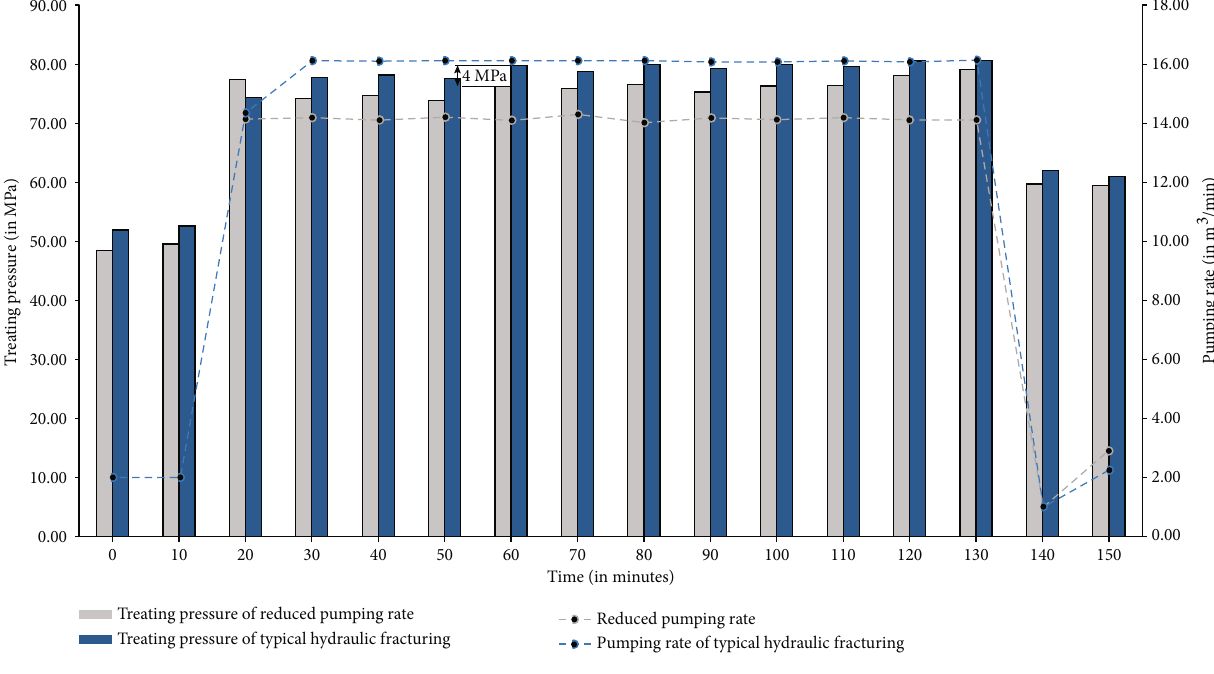
Figure 14: The comparison of treating pressure corresponding to di ff erent pumping rate.